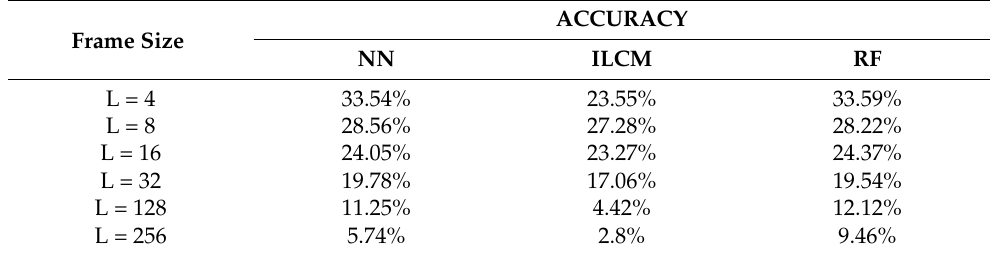
Table 5. Classification accuracy of NN, RF and the ILCM model for a particular frame size.